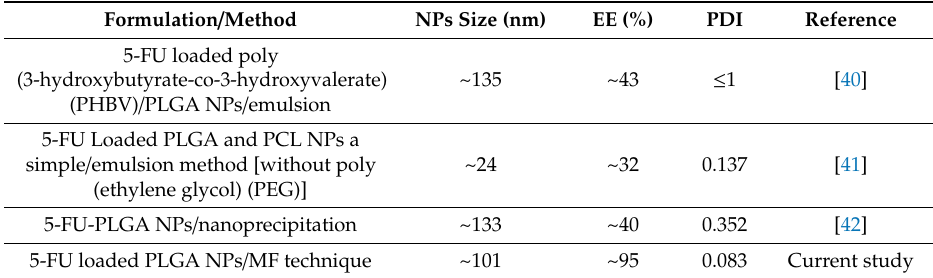
Table 1. A comparison between MF-based PLGA NPs and the NPs produced by other conventional methods in terms of size, polydispersity index (PDI) and encapsulation e ffi ciency (EE) values reported in the literature.